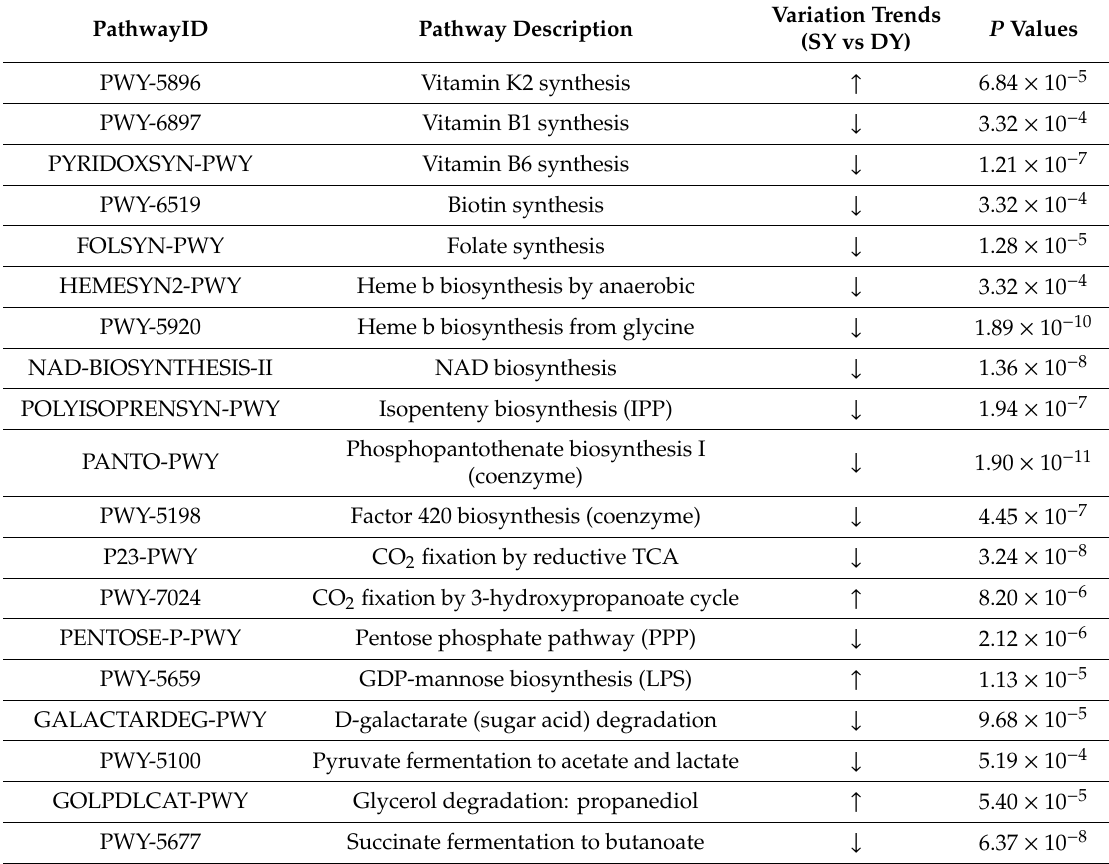
Table 3. Significantly di ff erent functional pathways related to coral microbiome between tropical (SY) and subtropical (DY) reefs (The ↑ and ↓ represent up- and down-regulated pathways,